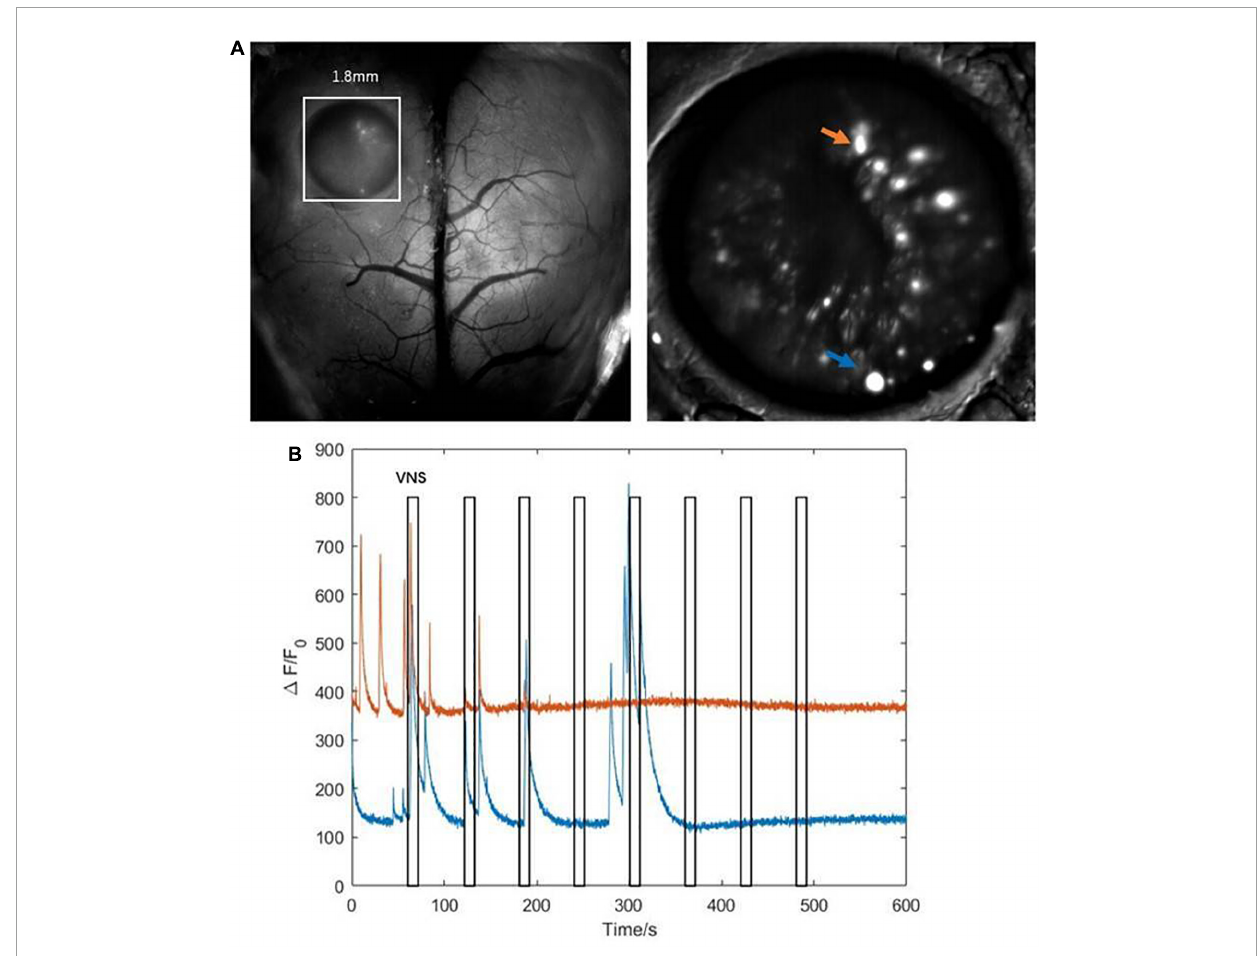
FIGURE5 Characteristics of calcium signaling of neurons in the hippocampal CA1. ( A left) The hippocampal CA1 region (white square: 1.8mm × 1.8mm); (right) two typical neurons extracted from hippocampal CA1 (orange arrow and blue arrow). (B) The curve diagram of neuronal activities of the two neurons (blue curve and orange curve corresponding to blue arrow and orange arrow shown in (A) , respectively). Narrow gray rectangles indicate time of each VNS application (lasting 10 s). Y-axis indicates neuron numbers.